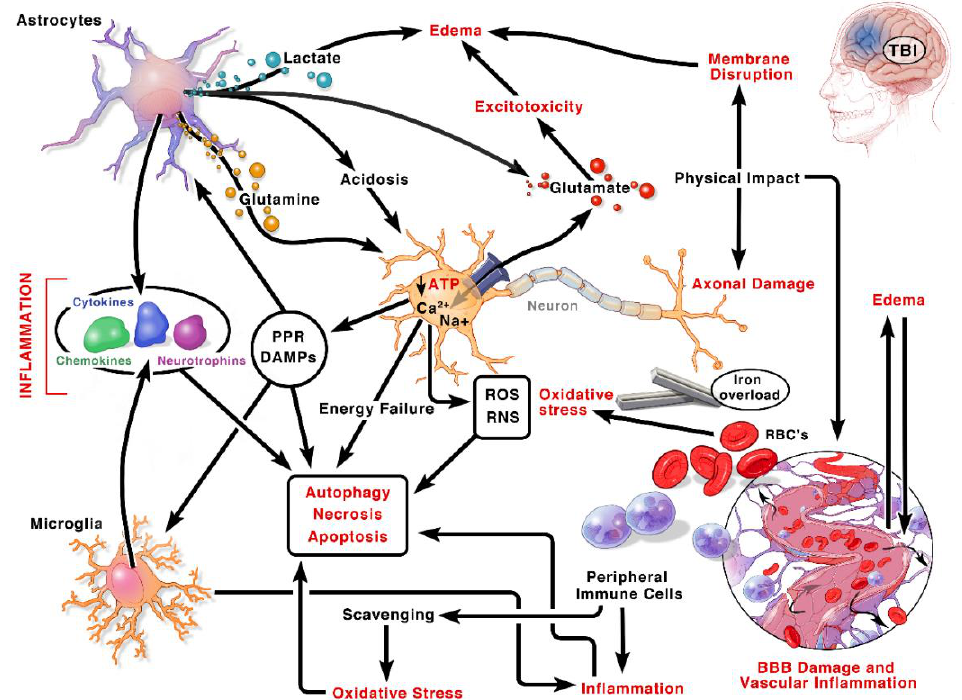
Figure 1. Pathophysiology of TBI. A schematic flow chart of the pathological changes after TBI that lead to acute and chronic neurovascular damage and immune activation. Immediately after the insult neurovascular damage occurs, and large amounts of DAMPs are released causing gliosis and peripheral immune cell infiltration. The initial function of these immune cells is to contain the injury and remove debris and dead cells. However, unregulated immune cells cause enhanced inflammation and injury progression. Furthermore, energy failure, oxidative stress, prolonged inflammation, and excitotoxicity lead to progressive injury with white matter damage and chronic behavioral deficits. Abbreviations: DAMP: Damage associated molecular patterns; PRR: Pattern recognition receptors; ROS: Reactive oxygen species; RNS: Reactive nitrogen species; RBC: Red blood cells; Na + : Sodium ion; Ca 2 + : Calcium ion; ATP: Adenosine triphosphate; TBI: Traumatic brain